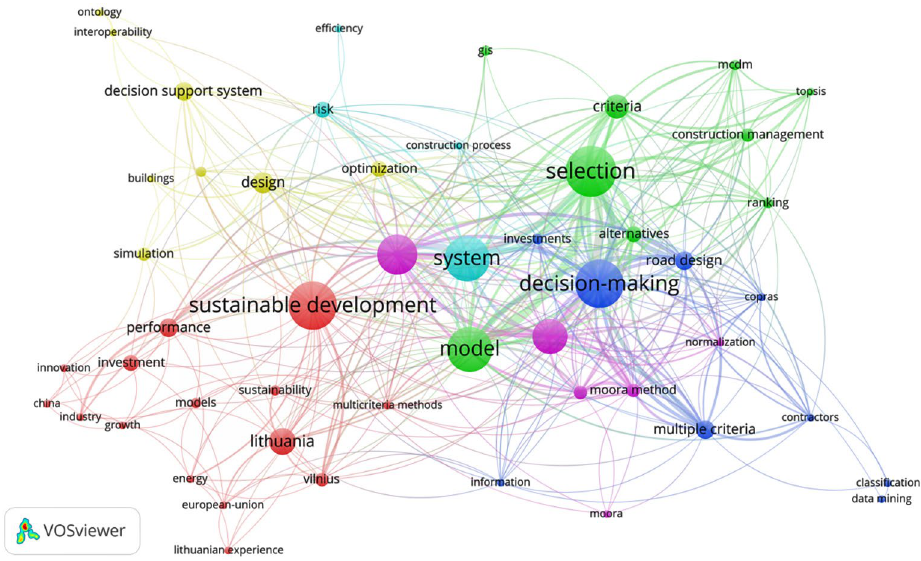
Figure 3. Co-occurrence network of keywords of the TEDE publications,